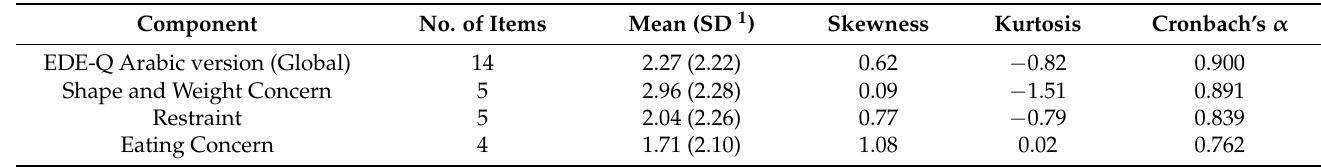
Table 6. Consistency and distribution of the EDE-Q Arabic version and items in each component.